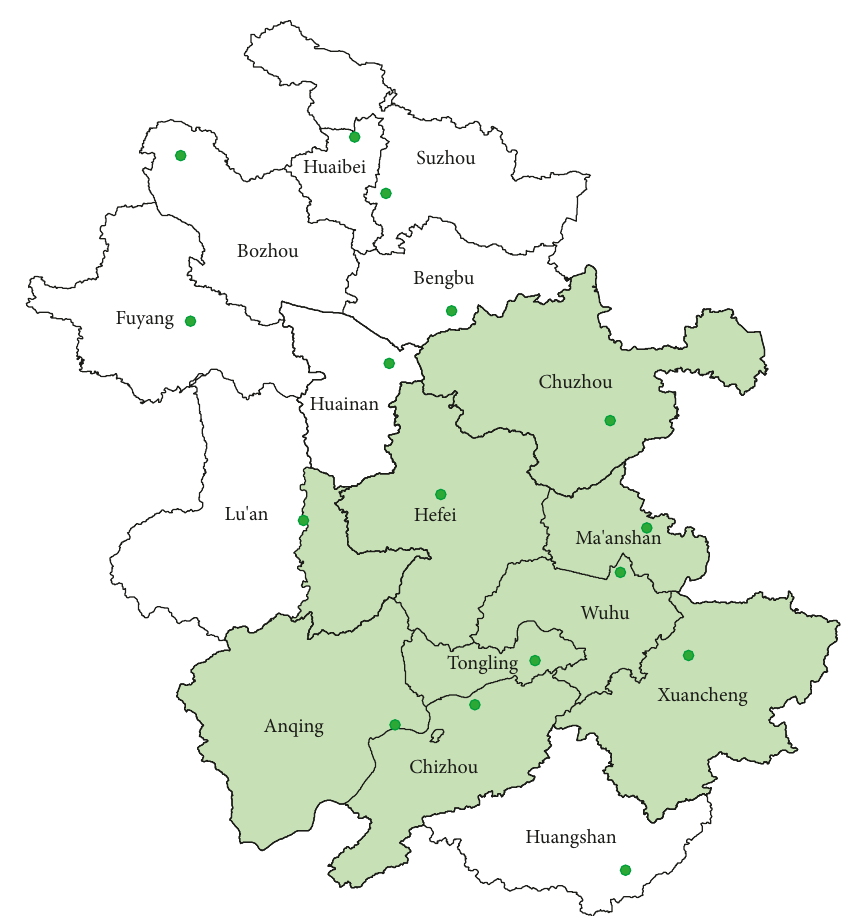
Figure 3: Distribution of CNEMC stations in